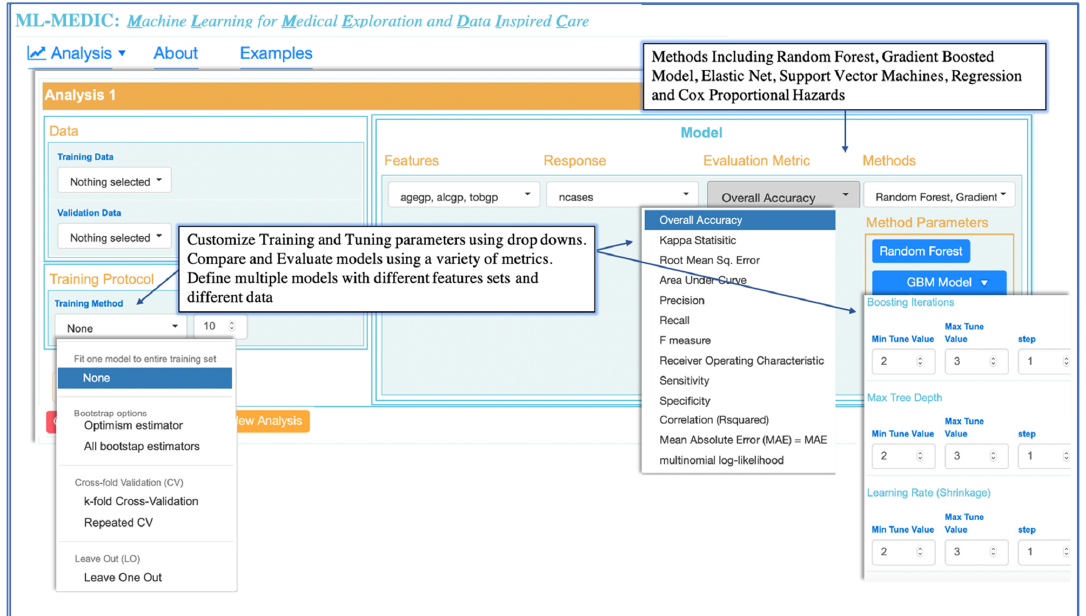
Figure 3. Overview of menus and options available for an analysis. Training protocols include bootstrap, cross-validation, and hold out methods. Accuracy metrics available for classification as well as numeric or multiclass models. Each available method contains a custom menu dropdown to define tuning parameters, with default values set based on standard practices and the data loaded for analysis. Each method or parameter available is defined in a modular manner to facilitate addition of other methods and features.